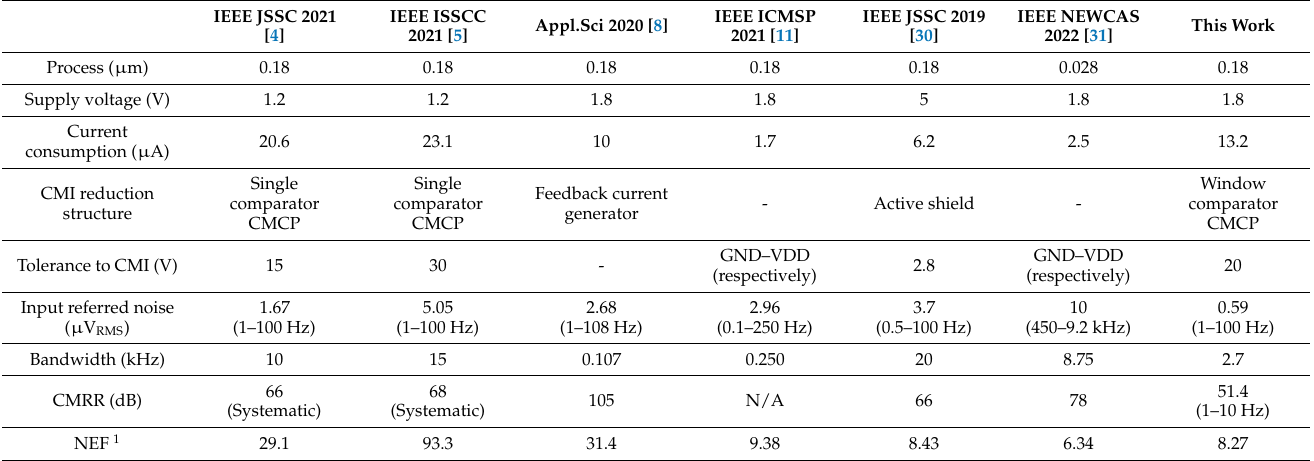
Figure 19. ECG signal acquisition result. ( a ) CMCP disabled; ( b ) CMCP enabled. Table 1 summarizes the performance of the proposed readout IC for ECG recording using the CMCP [4,5,8,11,30,31]. The proposed readout circuit has low power consumption and low noise characteristics. In addition, the 20-V PP CMI tolerance characteristics can be verified. Table 1. Performance summary between the proposed readout circuit and previous studies.